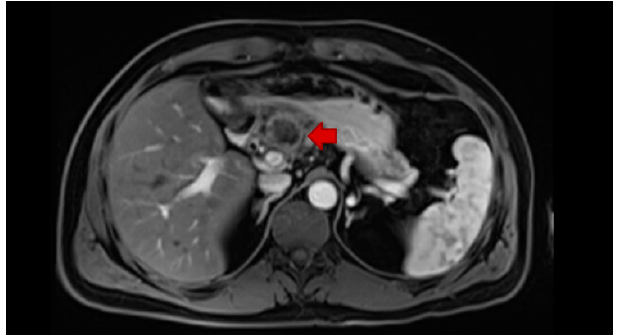
Figure 2. Gastrohepatic lymph node recurrence (short red arrow) in a patient who previously underwent left hepatectomy without porta hepatis lymphadenectomy for ICC.